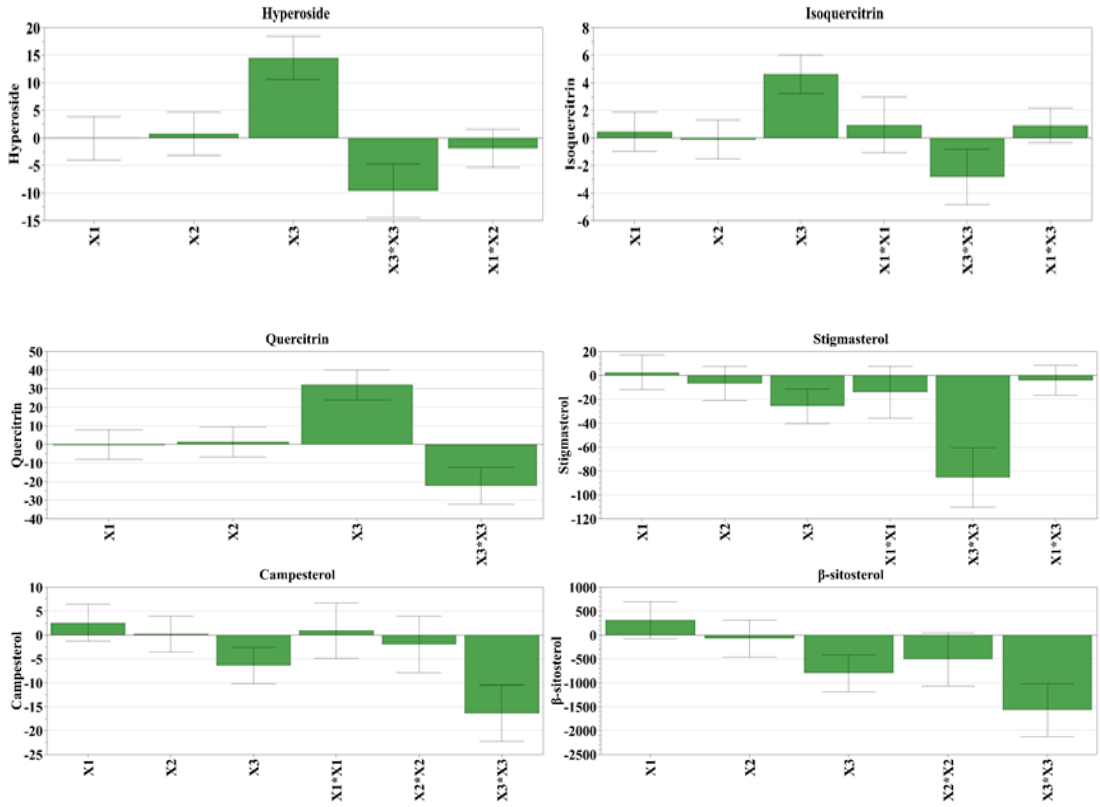
Figure 3. Influence of working conditions on the bioactive compound recovery from hazelnut involucre extracts, depicted as scaled and centered coefficient plots. X 1 , stirring time (min); X 2 , pH; X 3 , water in solvent (% v/v ).